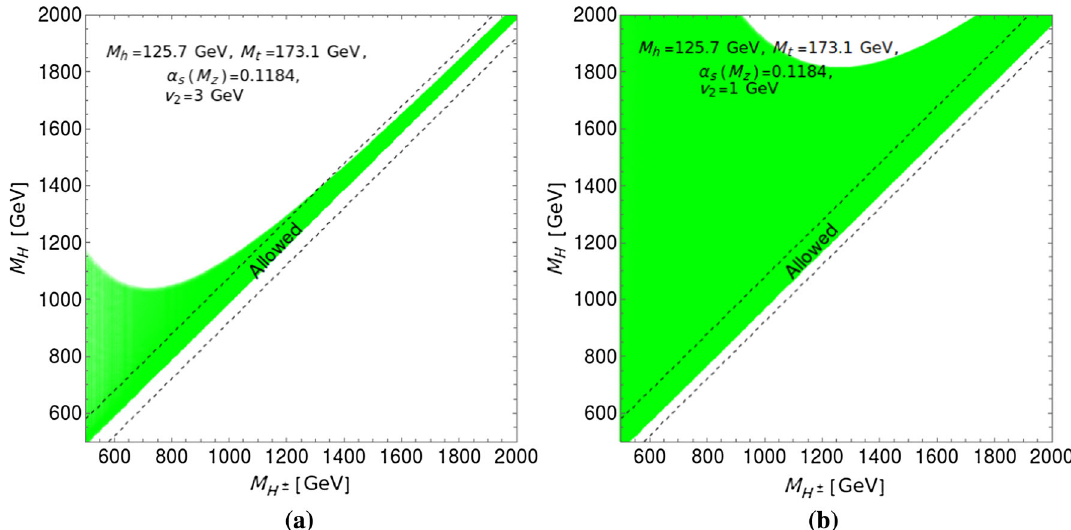
Fig. 1 The allowed region (green) from the unitarity, perturbativity and absolute stability which is valid up to the Planck mass M Pl . The region between the black-dashed line is allowed from the EWPT data at 2